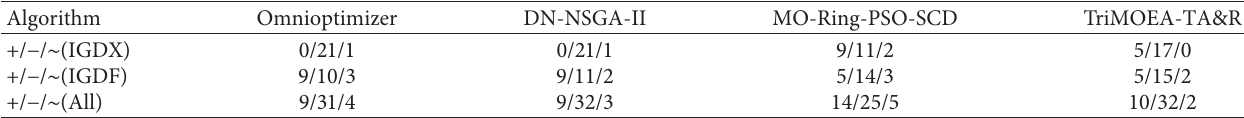
Table 2: The summarized results of other MMOEAs with MMOEA-CAS.